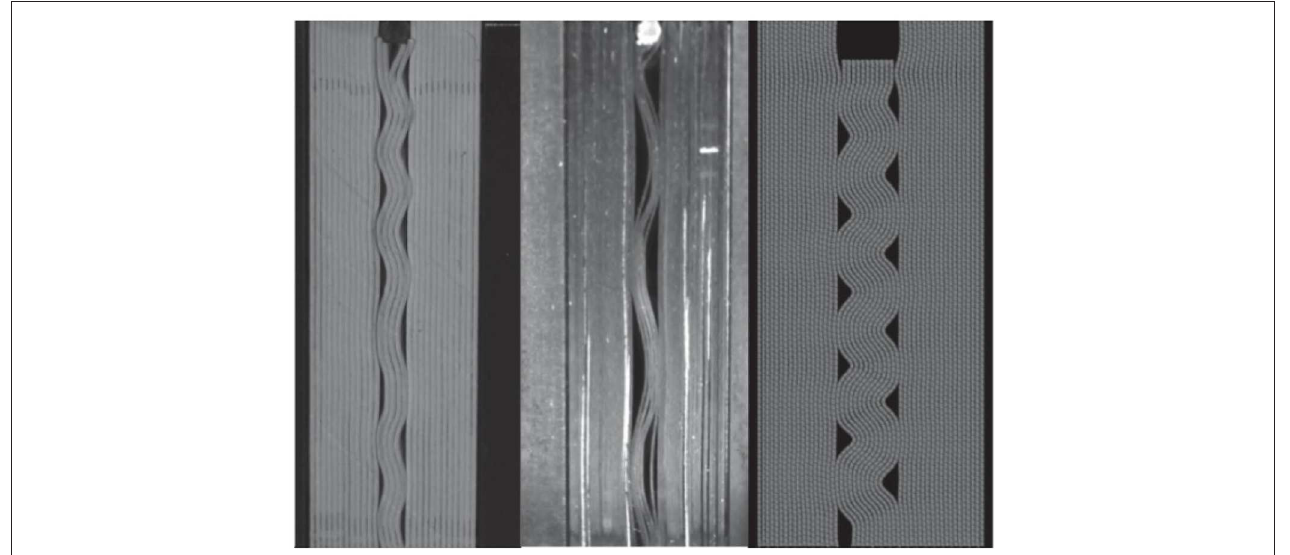
FIGURE 11 | Snapshots of RBs formed when a cylindrical indenter is loaded edge-on into plastic cards (left) , thin steel plates (middle) , and graphite (right) . The latter is a result of a MD simulation. The scales are intentionally not shown.